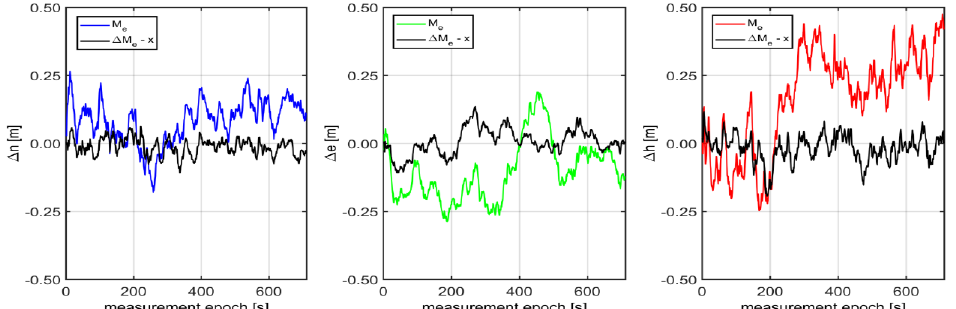
Figure 10. The median 𝑀𝑒(𝑡) values and the ∆ 𝑀𝑒−𝑋 (𝑡) values based on observations at the stations: REF1, REF2, REF3 and REF4 calculated with the use of the Kalman filter.